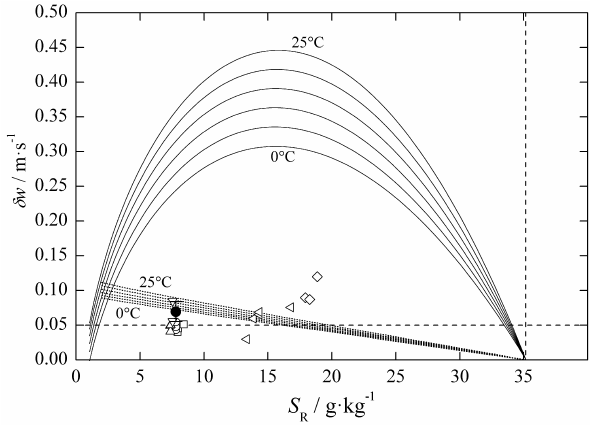
Figure 6. Experimental data for sound speed anomaly δw in Baltic seawater (symbols) in comparison to model results (curved lines, reproduced from Fig. 25 in Feistel et al., 2010a) at atmospheric pressure. Filled symbol: average of laboratory measurements in a sample with S R = 7.803gkg − 1 ( S P = 7.766) at temperatures of 1 to 46 ◦ C. Open symbols: data derived from off-shore measure- ments; see Fig. 5. The dotted lines show δw = w TEOS10 (S A,dens = S A ) − w TEOS10 (S A,cond = S R ) calculated with Eq. (2) for different temperatures. The horizontal dashed line indicates the uncertainty of TEOS-10 sound